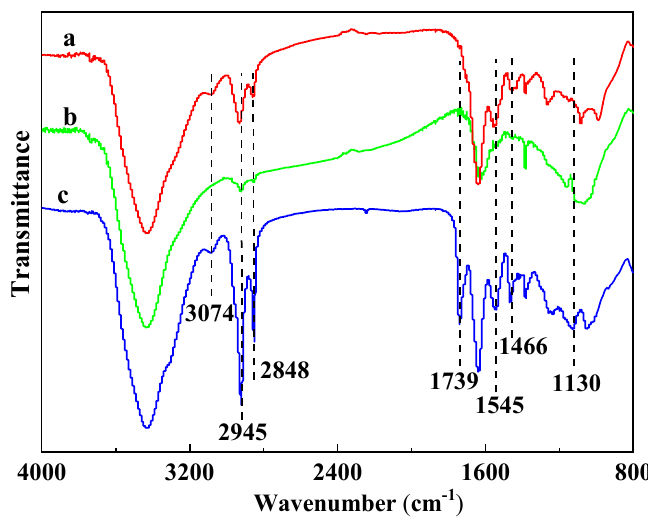
Figure 7. FTIR curves of the residues from the UL94 test: ( a ) 5.1%PI / PA66, ( b ) 17.0%MPP / PA66, ( c ) 11.9%MPP / 5.1%PI / PA66.